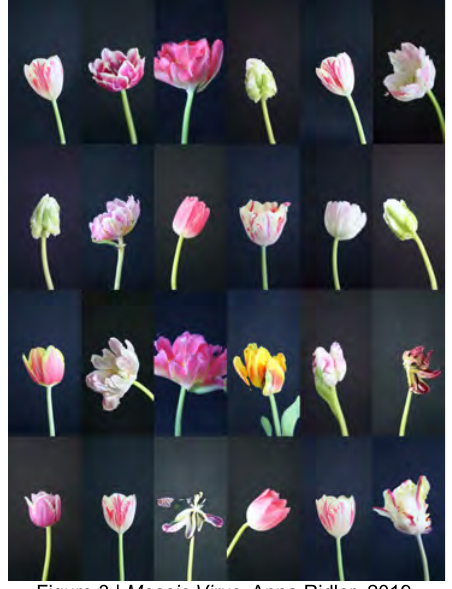
Figure 3 | Mosaic Virus , Anna Ridler,